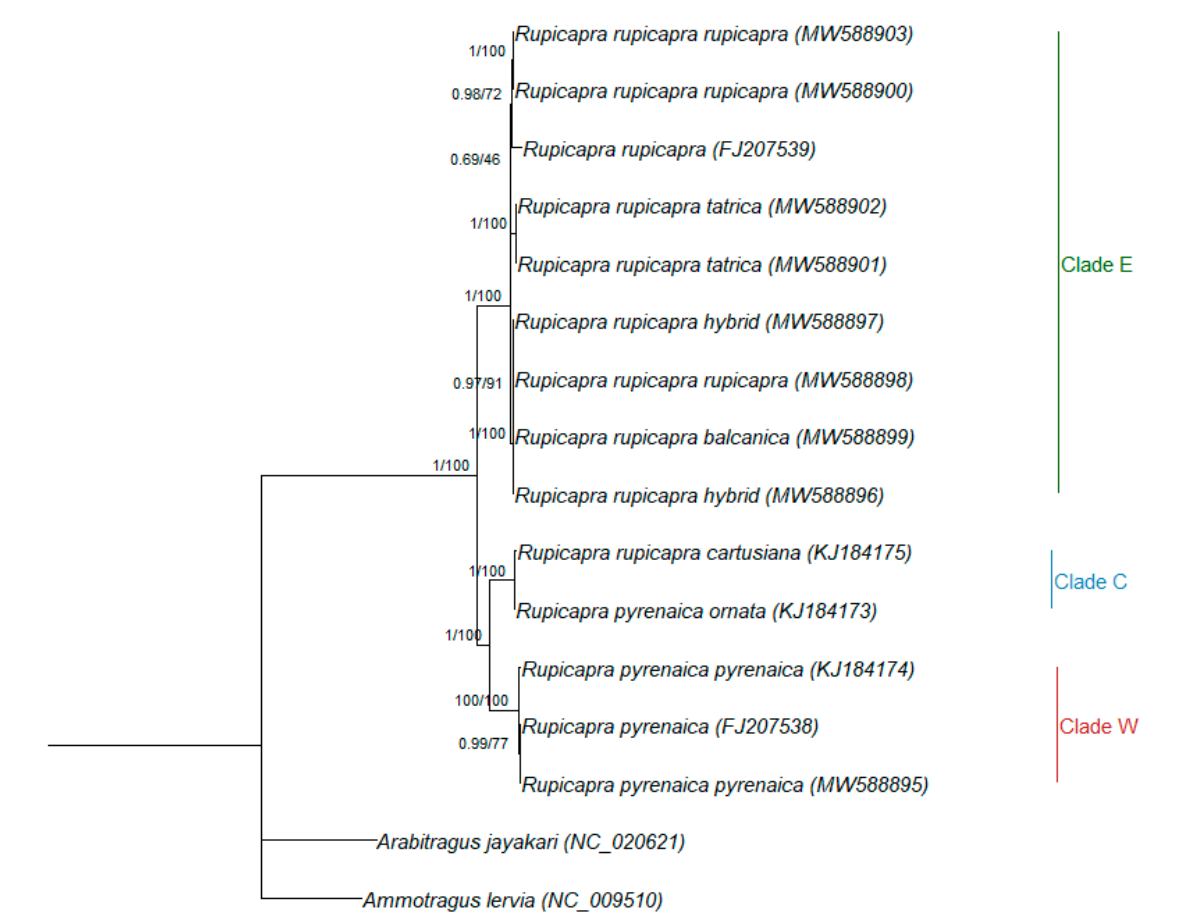
Figure 3. Rooted phylogenetic tree obtained by Bayesian inference for Rupicapra only. Nodal supports are indicated above the nodes (posterior probability for Bayesian inference and bootstrap percentages for maximum likelihood, respectively). GenBank Accession numbers are presented in parentheses.